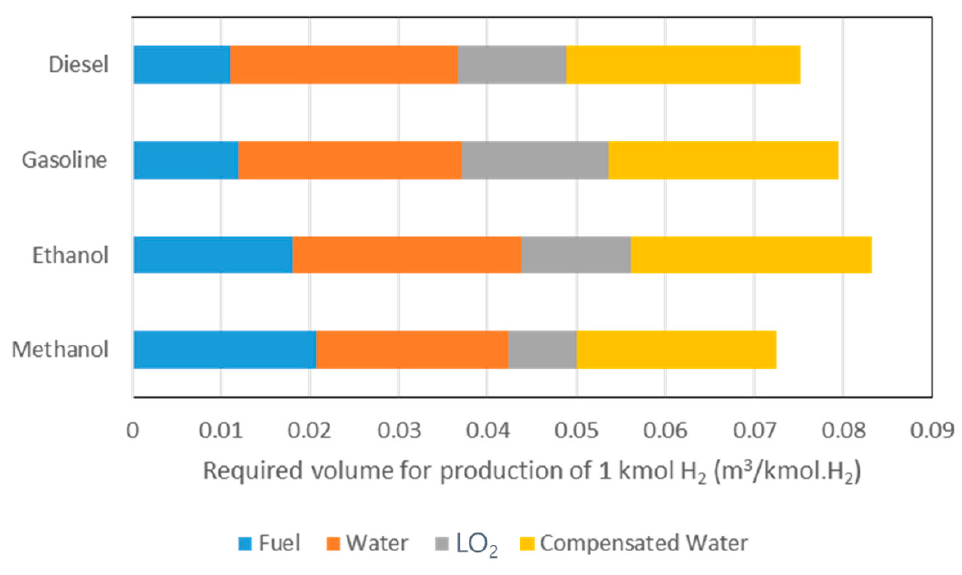
Figure 6. Required volume per produced H 2 (1 kmol) for diesel, gasoline, ethanol, and methanol.